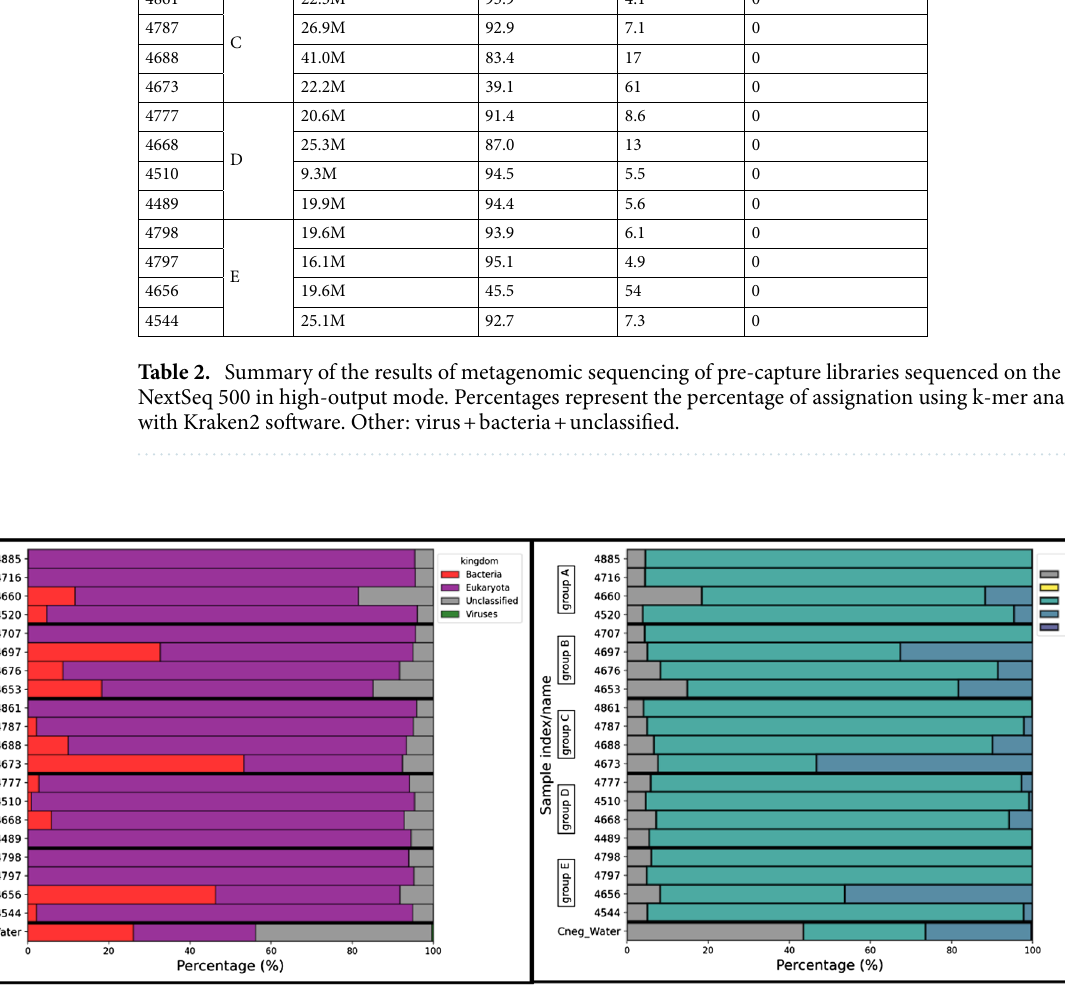
Figure 3. Metagenomic analysis of the pre-capture libraries using Kraken2 software. In the left image, we observe the taxonomic classification at the taxon level. In the right image, several databases were sequentially used, in this order: SARS-CoV-2, human genome, bacteria and viruses. We can observe that most sequences from the 20 samples are classified. Most samples had 95% eukaryotic content (human) and some showed the presence of bacterial sequences of up to 40% (in red on the left panel and blue on the right panel). However, almost no viruses (including SARS-CoV-2) were detected, as represented in both